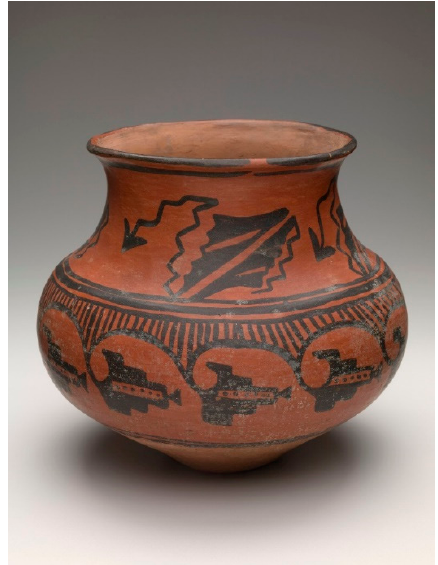
Figure 4. San Ildefonso Pueblo Jar made by Dolorita Vigil. Purchased by the Museum of the American Indian from an unknown source in 1949. Possibly created between 1880 and 1920. 21/3333. Used by permission of the Smithsonian Institution, National Museum of the American Indian.